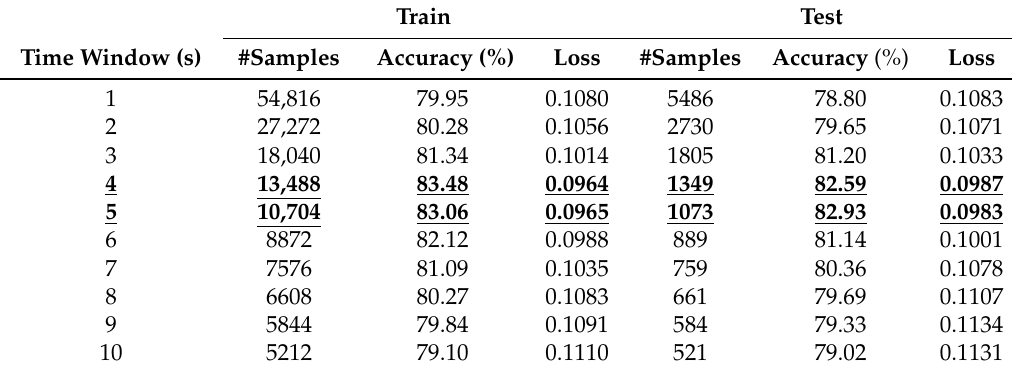
Table 2. Results obtained with GSR network classifying Arousal (best time windows are marked). Train